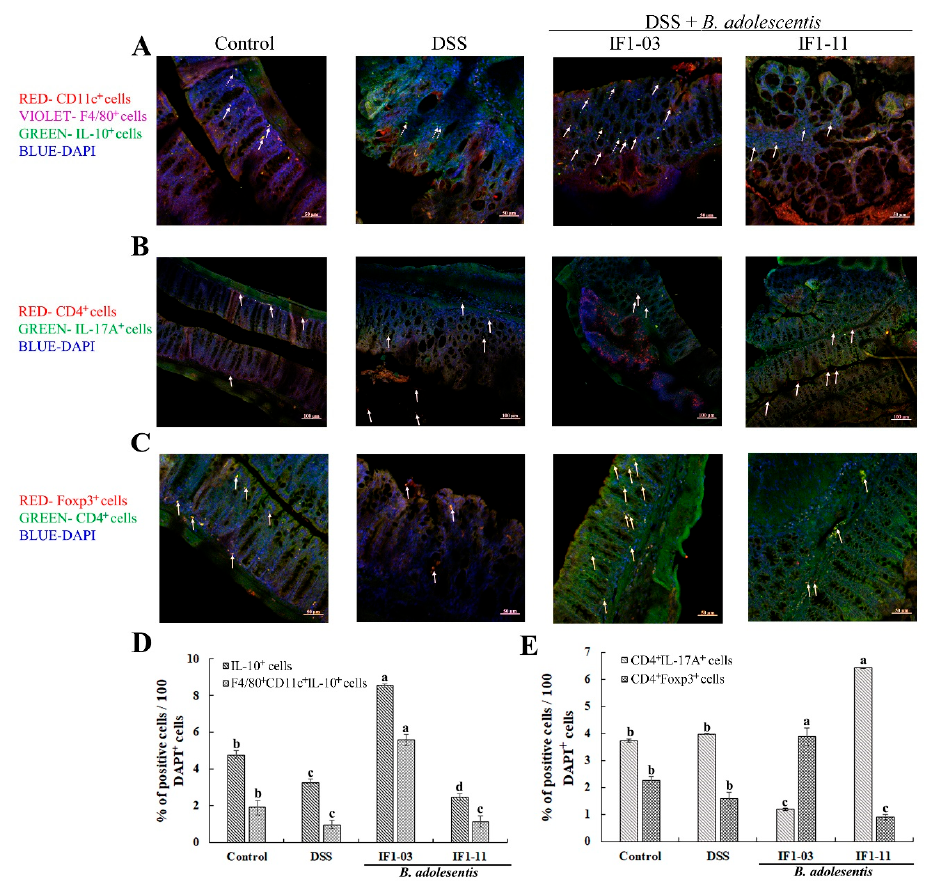
Figure 4. Effect on induction and distribution of Treg (CD4 + Foxp3 + )/Th17 (CD4 + IL17A + ) cells and IL-10-producing CD11c + DCs or F4/80 + macrophages in colon tissue of C57BL/6 control mice (placebo, per os), DSS-colitis model mice (6 days DSS, ad libitum, days 9–15) or B. adolescentis strain IF1-03/IF1-11 protection of DSS-colitis mice (15 days bifidobacterial cells per os, with DSS ad libitum on days 9–15). Mouse colon sections were stained with CD11c (red dots), IL-10 (green dots) and F4/80 (violet dots) antibodies ( A ), CD4 (red dots) and IL-17A (green dots) antibodies ( B ), or CD4 (green dots) and Foxp3 (red dots) antibodies ( C ). Microfluorescence image visualized by Zeiss LSM 710 Confocal System. In (A), representative DCs (CD11c + F4/80 - IL-10 + ) (dotted arrow) and macrophages (CD11c + F4/80 + IL-10 + ) (solid arrow) in the four mouse groups are indicated. In (B) and (C), representative Th17 (CD4 + IL17A + ) and Treg (CD4 + Foxp3 + ) cells in the four mouse groups are indicated by solid arrows. Bars = 50 μ m (200×) in (A) and (C) and 100 μ m (100×) in (B), respectively. Proportion of IL-10 producing cells (IL-10 + ), IL-10 producing macrophages (CD11c + F4/80 + IL-10 + ), Th17 cells (CD4 + IL-17A + ) and Treg cells (CD4 + Foxp3 + ) in mice of the four groups. IL-10 producing cells, IL-10 producing macrophages (CD11c + F4/80 + IL-10 + ) ( D ), Th17 cells (CD4 + IL-17A + ) and Treg cells (CD4 + Foxp3 + ) ( E ) in mice of the four groups was numbered and analyzed by using ImageJ software. Data are shown as mean ± SD for three independent experiments and those with same signs and labelled with different letters are significantly different by one-way ANOVA (* p < 0.05).